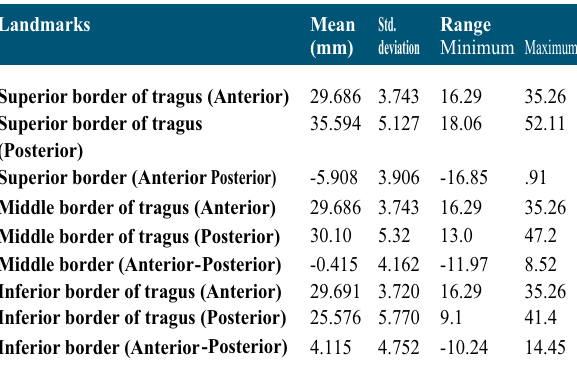
Table 1: Descriptive statistics for distances between maxillary occlusal plane and other